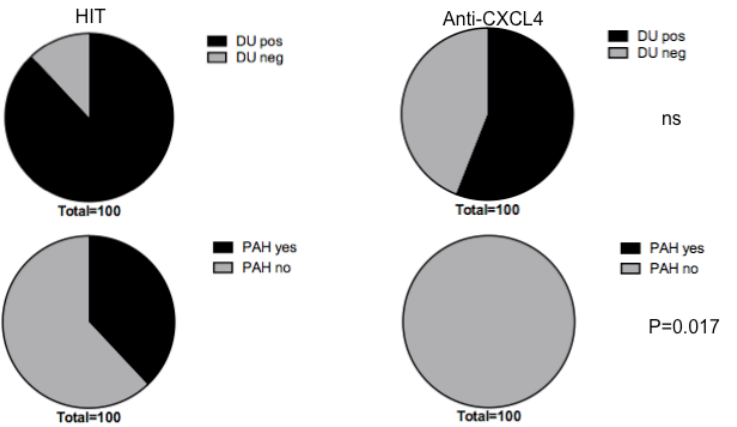
Figure 7. Heparin-dependent anti-CXCL4 antibodies may be linked to PAH. Percent of patients expressing HIT or heparin-independent anti-CXCL4 antibodies (anti-CXCL4) is shown in DU positive and negative patients, upper pie diagrams, or in patients with PAH or with no PAH, lower pie diagrams. More than 1/3 of PAH positive patients have HIT antibodies and the difference, calculated by Chi-square’s test is significant. p values reported in the